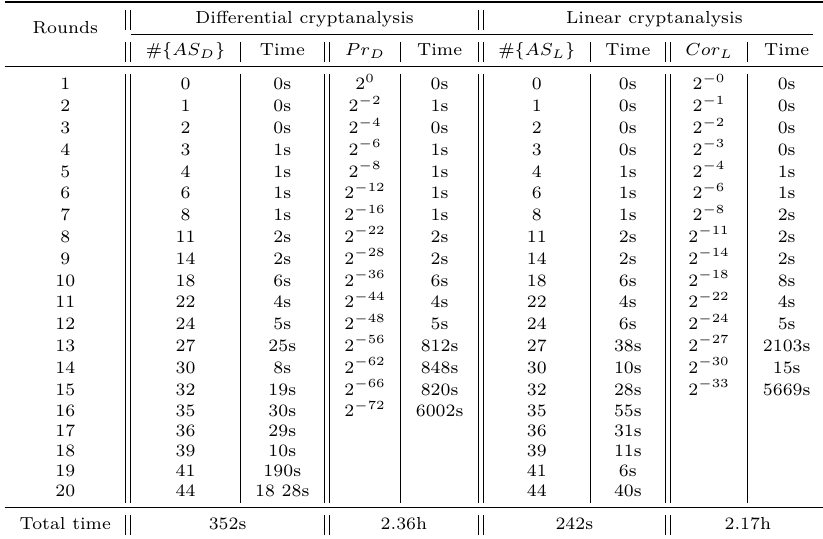
Table 5: Experimental results of LBLOCK